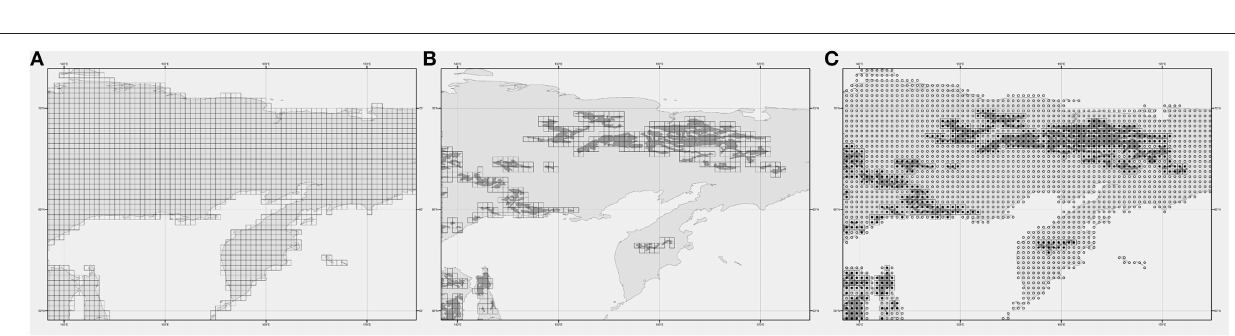
FIGURE 1 | Study area domain represented by black borders limiting the Russian Federation territory. The parallel limiting the Arctic Circle is shown in gray-black/dashed line.